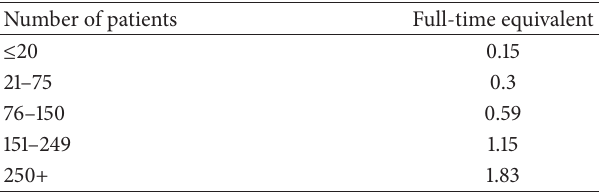
Table 1: Clinic director/CF physician.